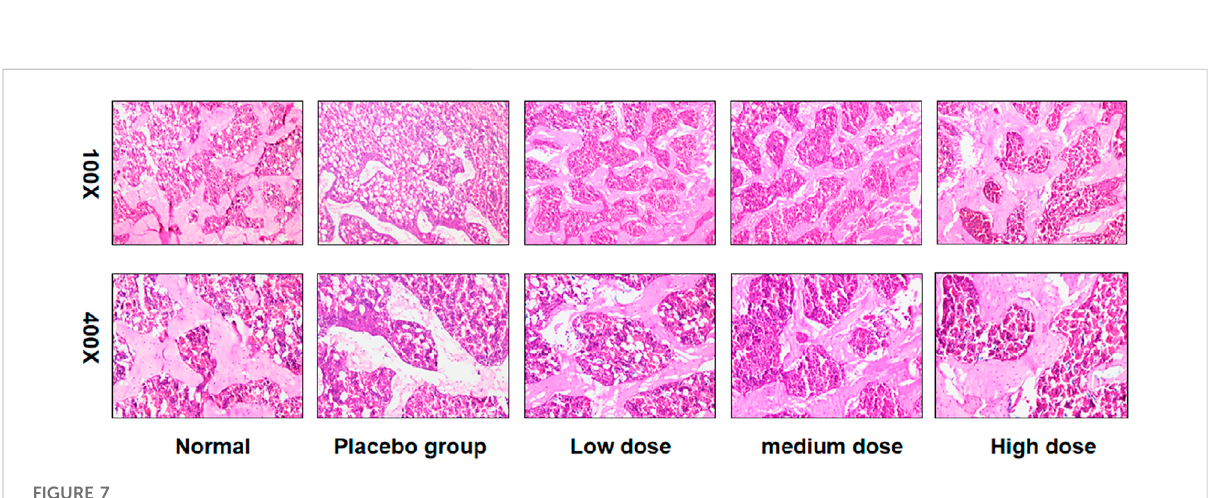
FIGURE 7 HE staining of bone tissue with different doses of